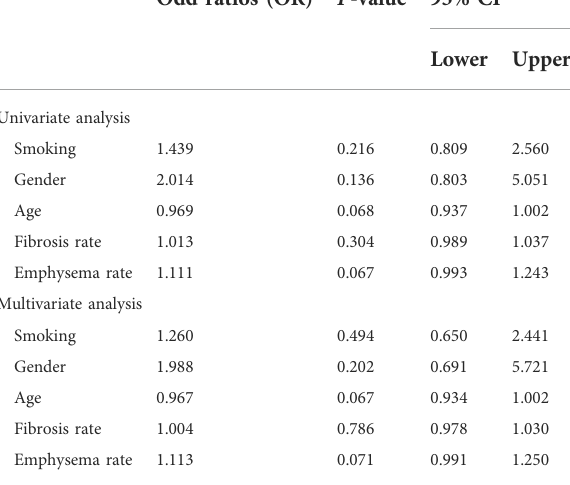
TABLE 4 Factors associated with small airway Dysfunction logistic regression